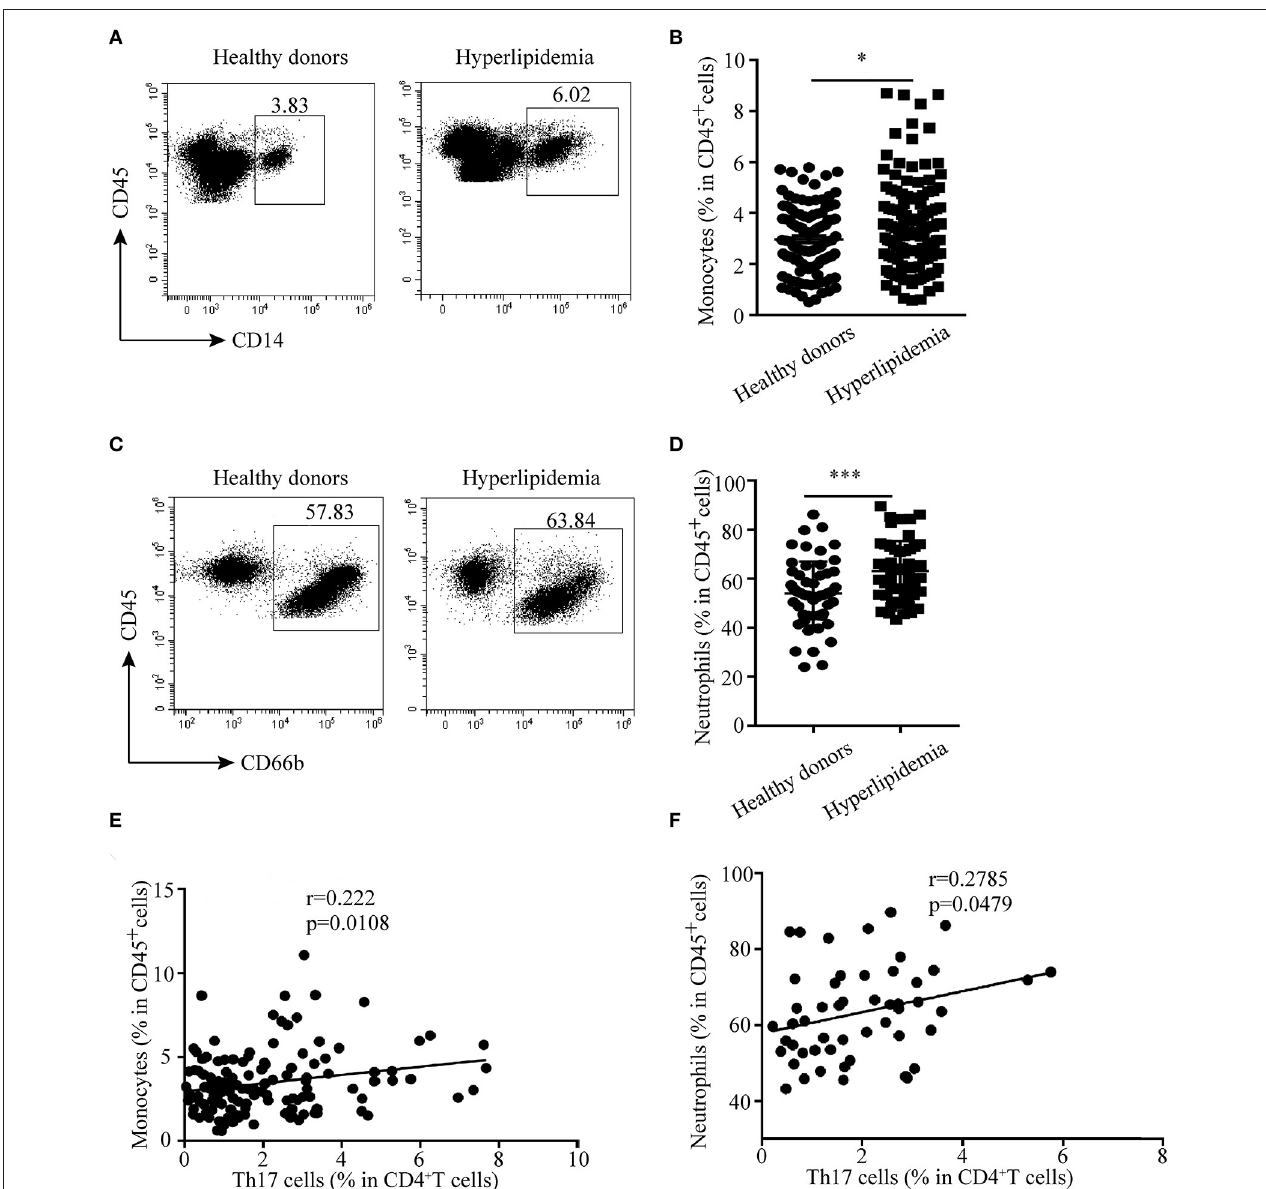
FIGURE 7 | Correlation between Th17 cells and monocytes and neutrophils in hyperlipidemic patients. (A,B) Percentages of monocytes (CD45 + CD14 + cells) in human peripheral blood. (C,D) Neutrophil (CD45 + CD66b + cells) percentage in human peripheral blood. (E) Correlation between Th17 cells and monocytes ( n = 129). (F) Correlation between Th17 cells and neutrophils ( n = 51). * p < 0.05, *** p <